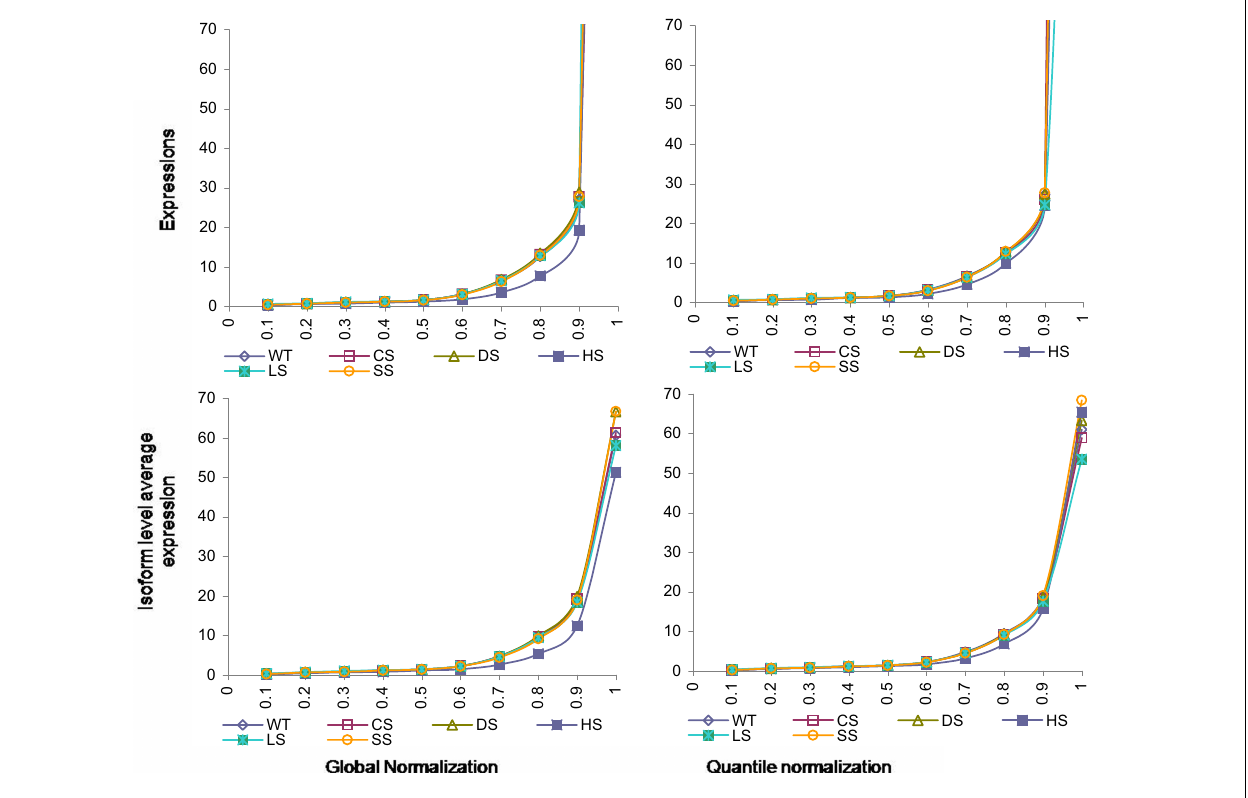
normalization (right). Bottom panel: isoform level average expression within each percentile under global normalization (left) and under quantile